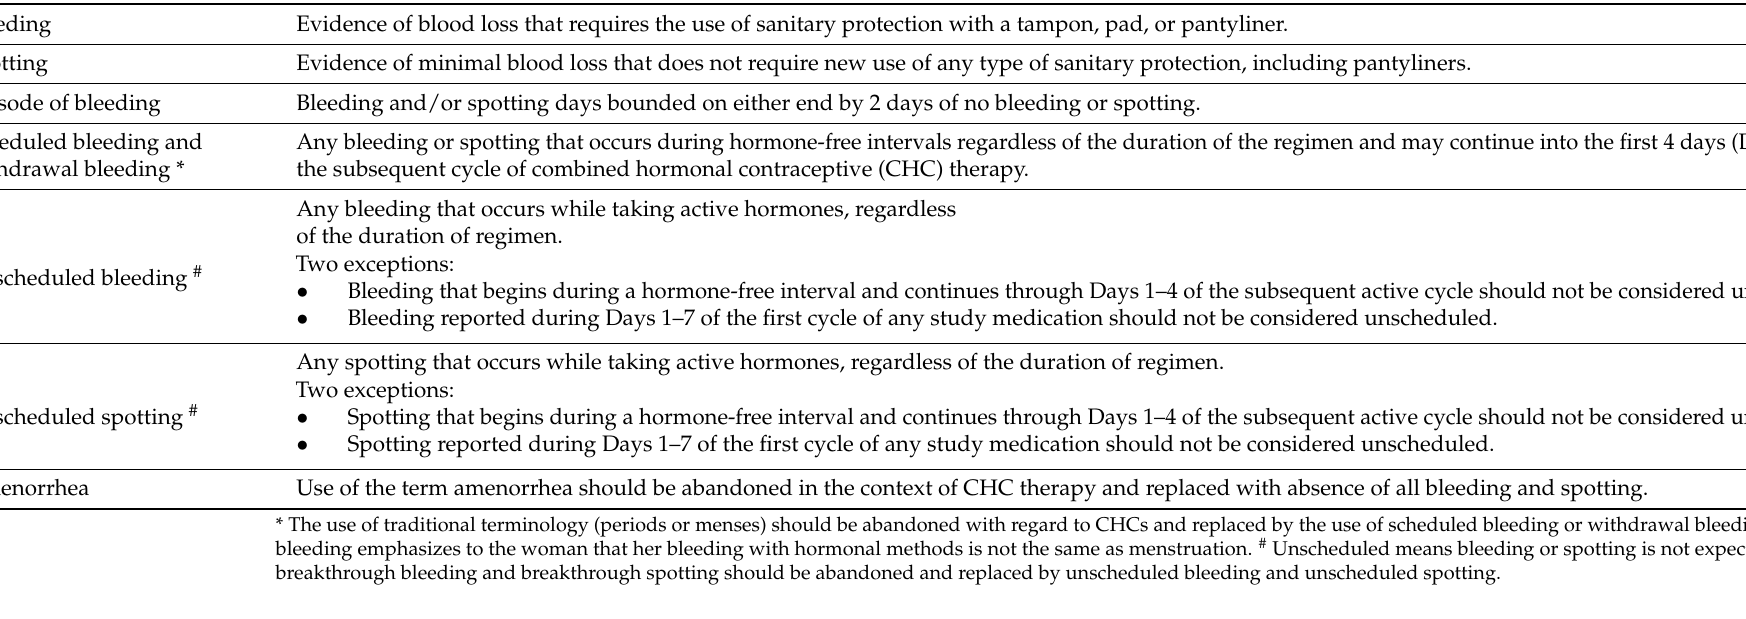
Table 1. Terminology and definitions according to Mishell et al.